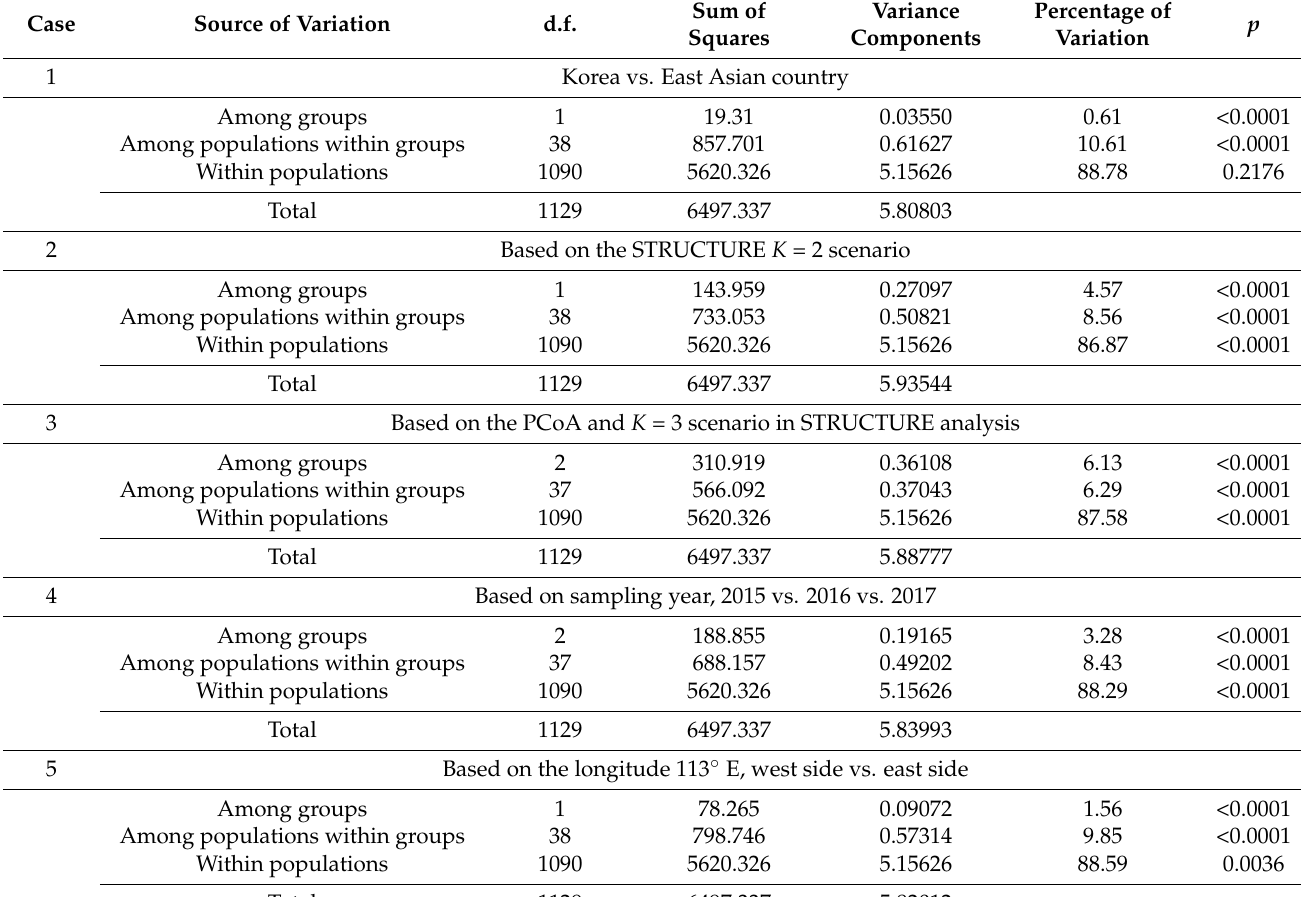
Table 2. Analysis of molecular variance (AMOVA) of 565 individuals in 40 populations of B. dorsalis in Korea and Southeast difference estimation. Case 4: Inference of group variability according to sampling year. Case 5: Based on the longitude 113 ◦ E, west side (CH YUN, IN, KH, LA, MM, MY, NP, TH and VN) vs. east side (CH FJS, CH SHA, KR and